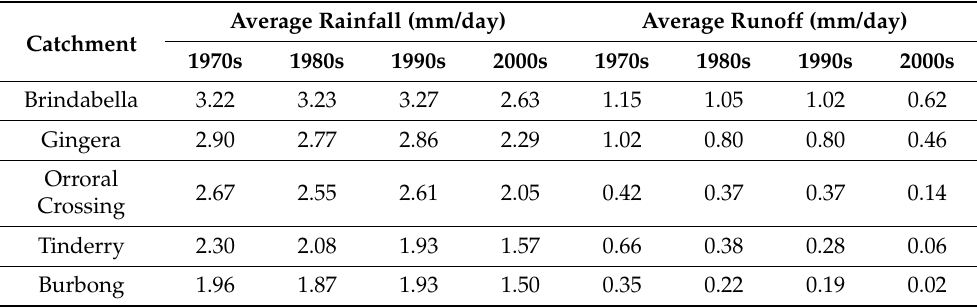
Table 1. Average rainfall and runoff over four decades of five